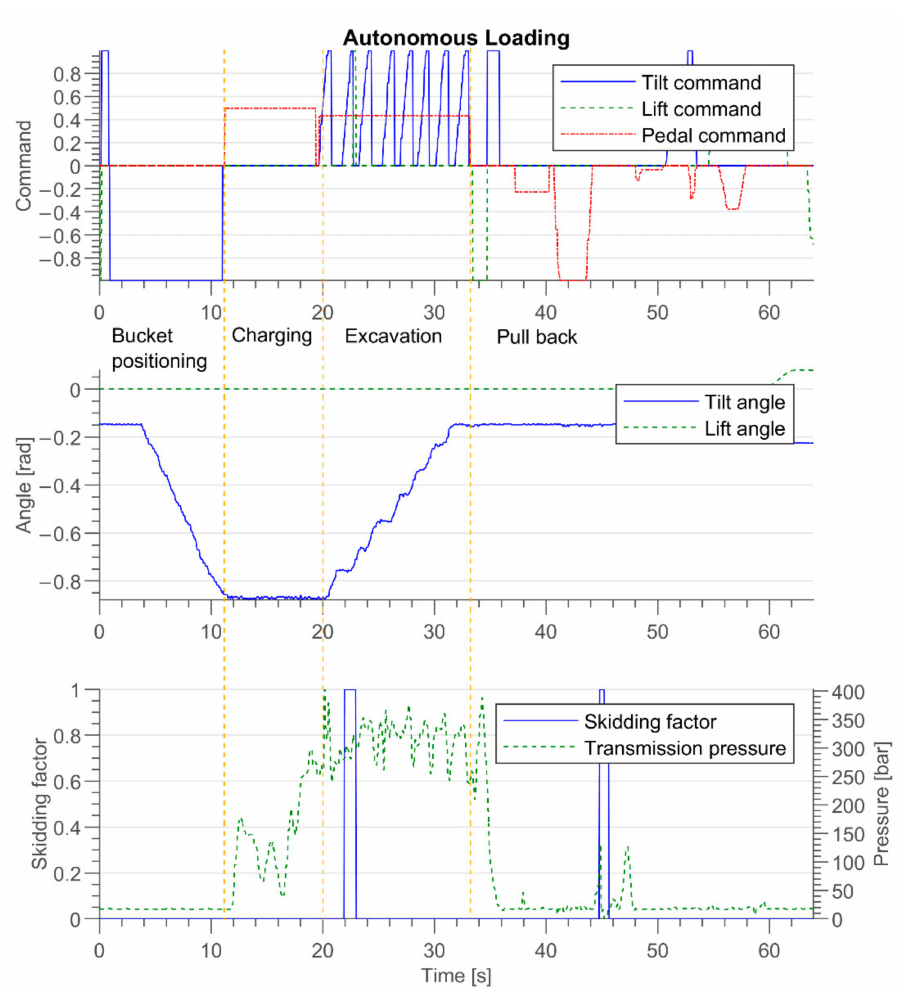
Figure 23. Relevant variables in an autonomous loading attempt. Table 3. Loading experiments and average fill factor per number of loading attempts. N-Attempts: